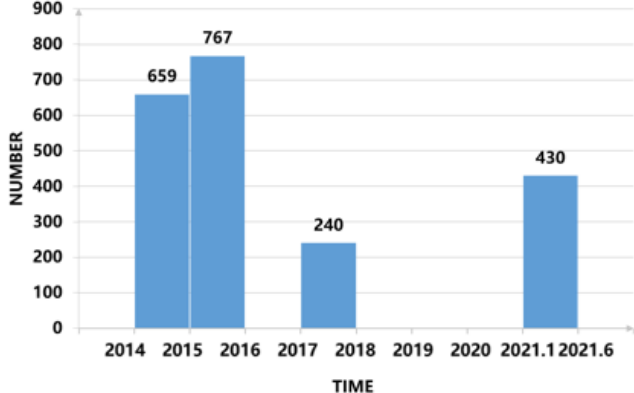
Figure 5. The composition of